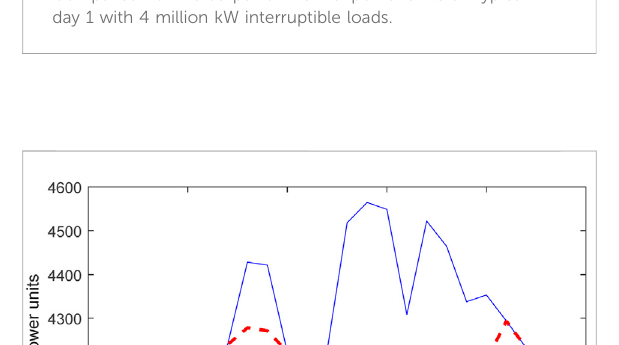
FIGURE 8 Output forecast of wind turbines on two typical days.